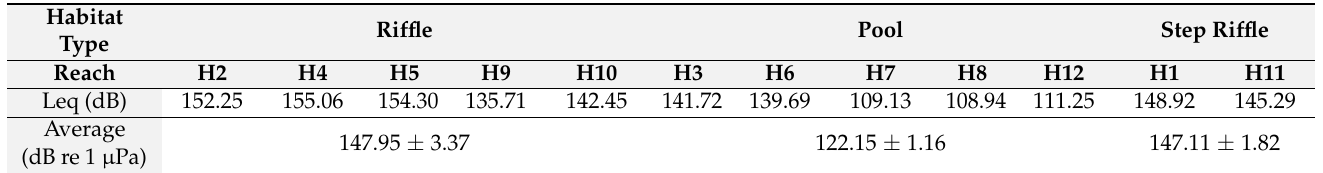
Table 2. Equivalent noise level of the surveyed habitat types.